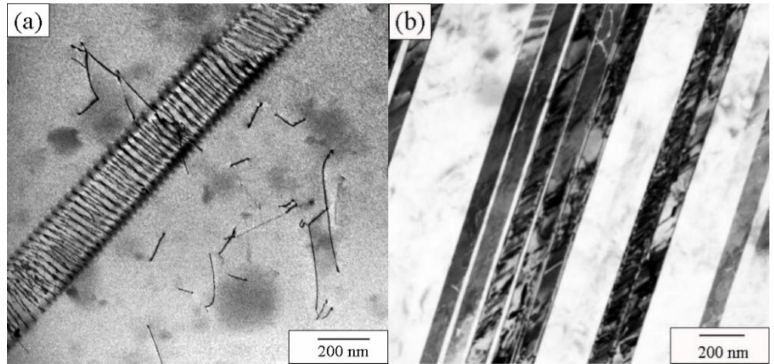
Figure 2. TEM photos before and after tensile test of 19CrSi–0.7N steel, ( a ) before, ( b ) after. For alloys with low SFE, the higher the critical shear stress of twins, it is difficult to form deformation twins [26,27]. Compared with 19CrSi–0.7N and 19Cr–0.7N TWIP stainless steel, the strength is reduced after the addition of the Si element, but the plasticity is greatly improved, which is related to the low SFE of the system. As mentioned, the SFE of the system with the addition of 1.5 wt.% Si is reduced by 3 mJ · m − 2 , and the deformation process is easier to induce Mts and further improve the plasticity. The relationship between the grain size and yield strength for evaluating the strengthening effect of the solid solution is described in formula (11):